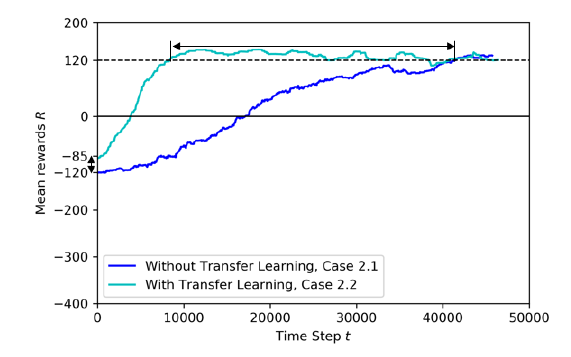
Figure 20. Training mean rewards for Case 2.1 and Case